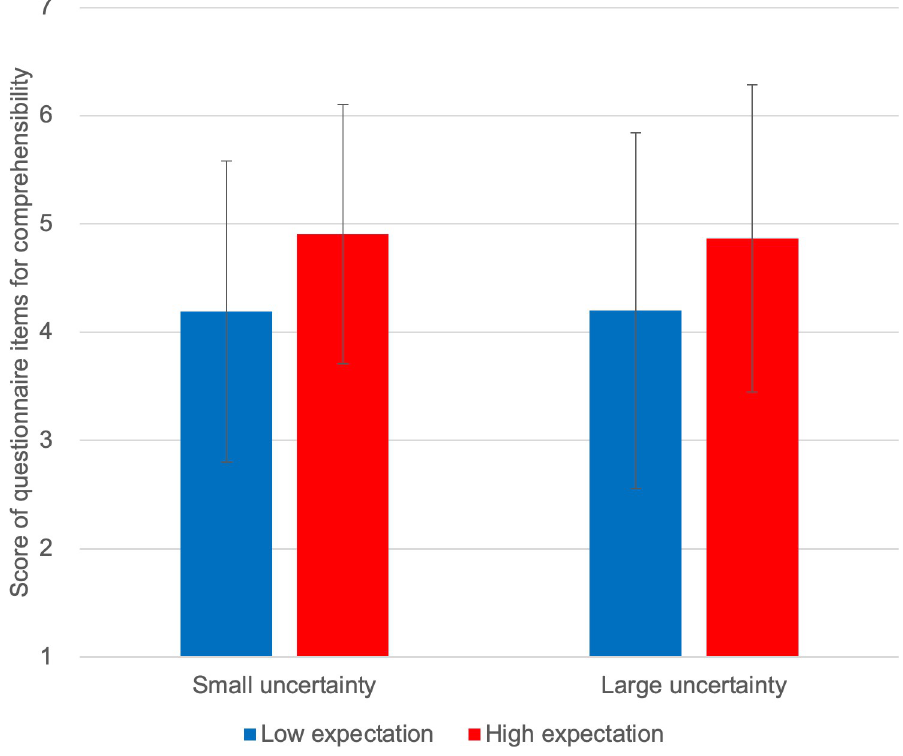
Fig 8. Self-reported